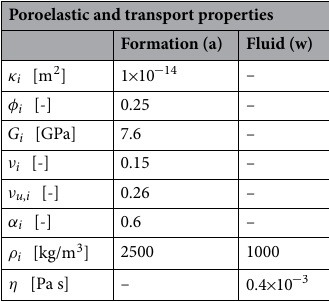
Table 1. Parameters used in the 2-D generic